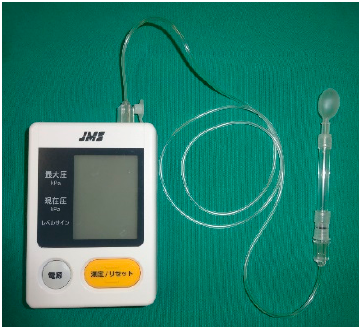
Figure 7 . Masticatory ability testing system